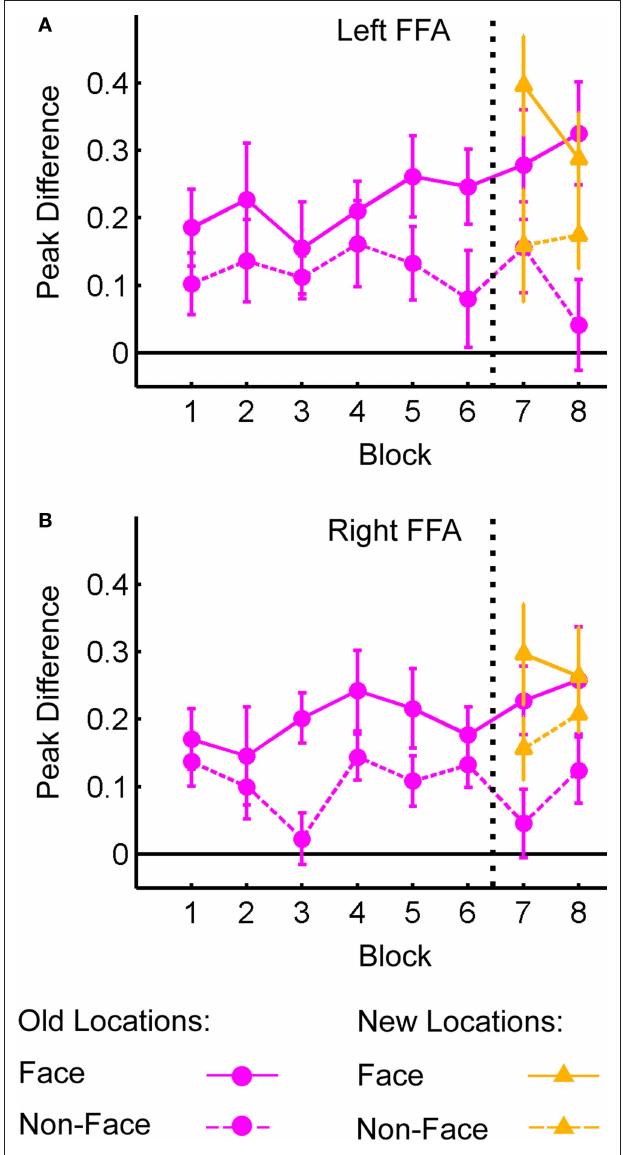
FIguRe 6 | Difference in peak BOLD response for distractor present vs. distractor absent trials as a function of Block in fusiform face area (FFA). Peak distractor signal shown for face and non-face distractors presented in old and new distractor locations. (A) Left FFA. (B) Right FFA.